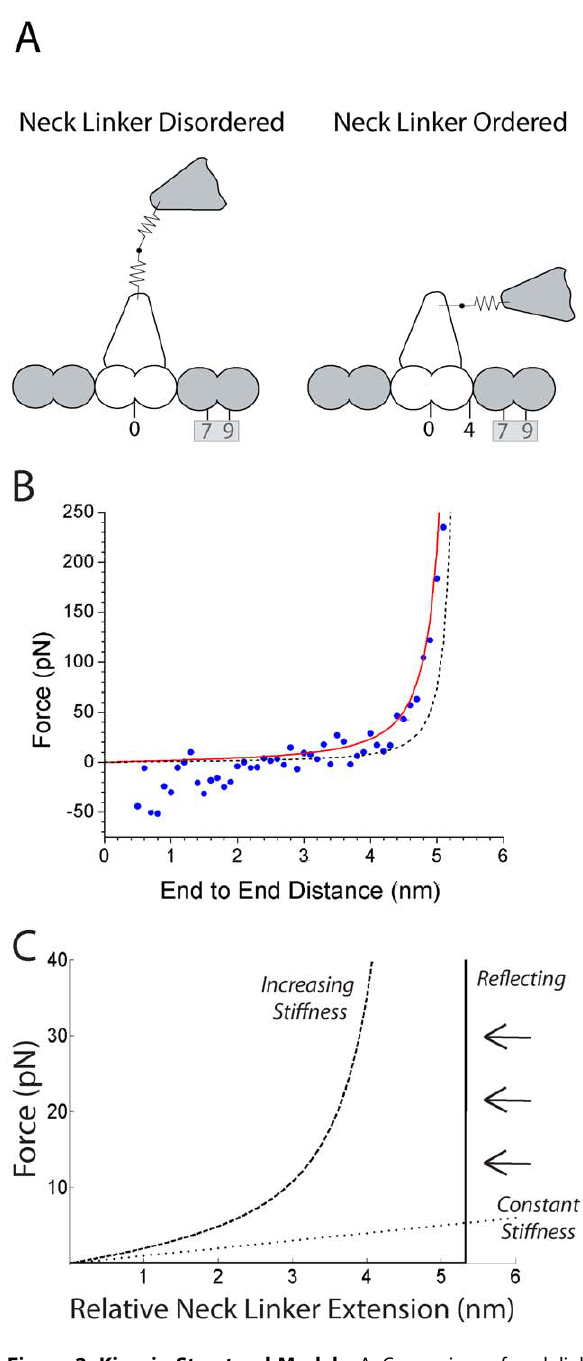
Figure 2. Kinesin Structural Models. A: Comparison of neck linker structures before and after docking. In state preceding ATP binding (left) the tether between the heads consists of both neck linkers (28 amino acids) with no forward bias (initial position 0 nm). Upon nucleotide binding (right), the rear neck linker docks to its motor domain, providing a 4.1 nm bias toward the microtubule plus-end. At this point the free motor head is tethered only by its 14 amino acid neck linker. The microtubule binding zone (7.2–9.2 nm, grey box) is defined as a region within 1 nm of the binding site. The motor is also permitted to bind to a site 8.2 nm to the rear (not shown), but this rarely occurs. B: Kinesin-1 force-extension profile from molecular dynamics simulations. Solid line shows fit to WLC with L p =0.7 nm and dashed line shows fit to WLC with L p =2 nm; both use L c of 0.364 nm per amino acid as described in text. Molecular dynamics results adapted from Hariharan and Hancock [21]. C: Force